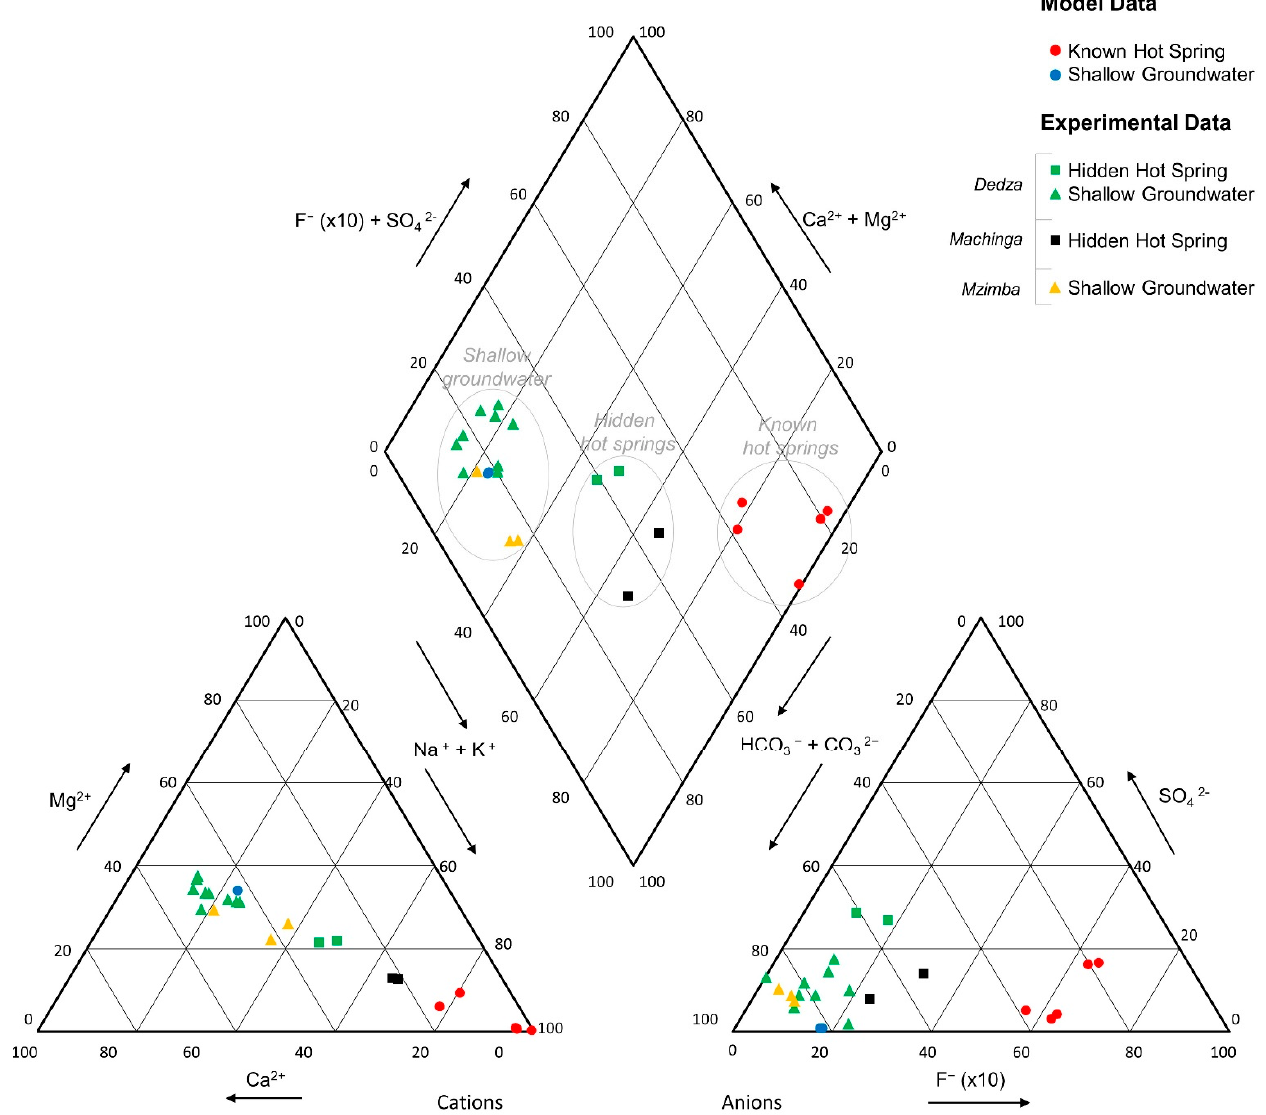
Figure 9. Piper plot displaying model data from endmember hot springs with complete hydrochemical profiles ( n = 5) [23], non-hydrothermal shallow groundwater with complete hydrochemical profiles ( n = 2) [26], and experimental data from Machinga, Dedza and Mzimba collected for this study.